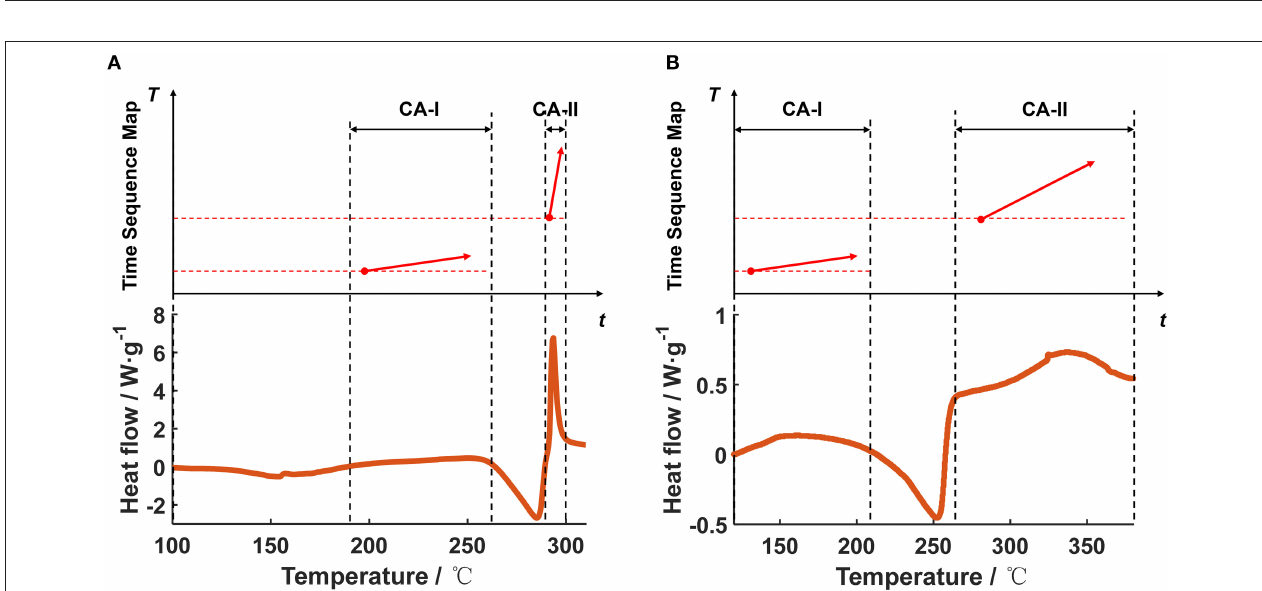
FIGURE 9 | Transformation of the DSC data into the segments in the Time Sequence Map, for the cathode system SYS ELE CA of (A) Battery Sample A, (B) Battery Sample B.